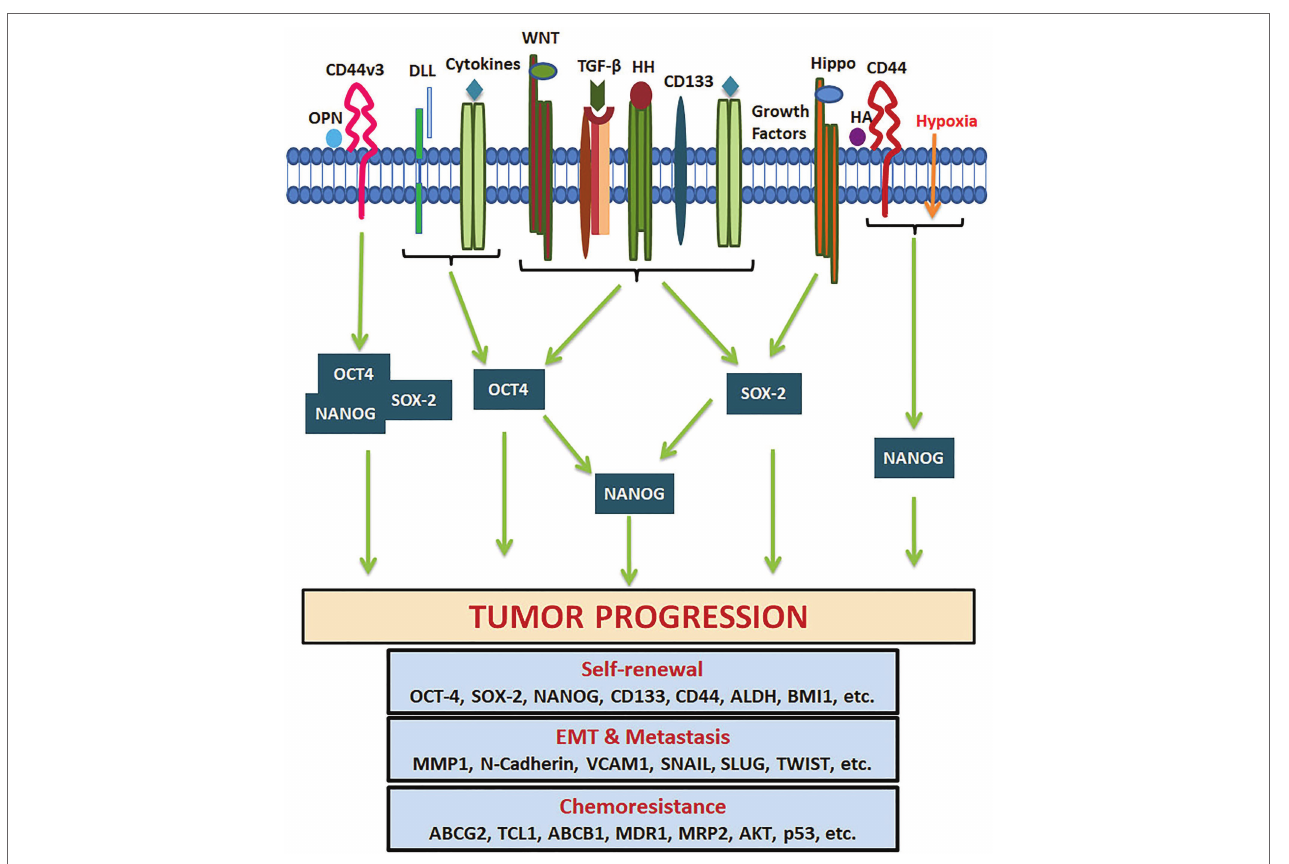
FIGURE 6 | Pluripotency genes in the regulation of tumor properties. Several tumor microenvironment factors and extracellular matrix components activate different signaling pathways that regulate the expression of OCT4, SOX-2, and NANOG. They either act alone or together for the transcriptional activation of genes responsible for CSC self-renewal, EMT, metastasis, cell survival, and